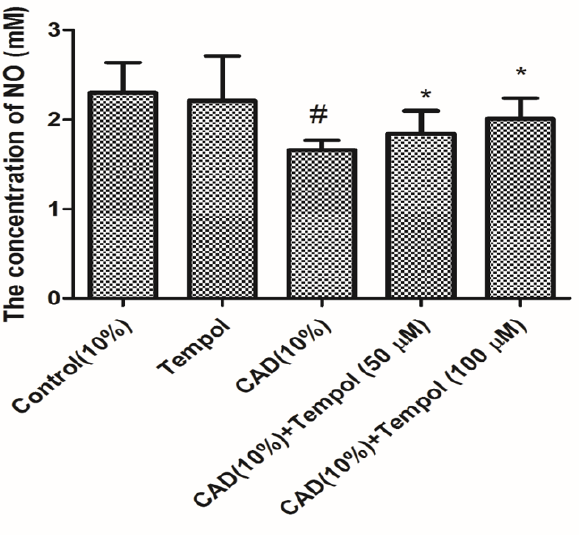
Figure 3: Effects of CAD serum on NOx levels in HUVECs. HUVECs were treated with 10% CAD serum+ tempol (50 or 100 µM) for 24 h, and the NOx level was assessed. *p<0.05, **p<0.01 vs. Control